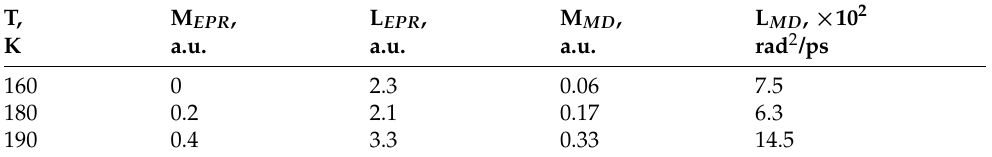
Table 1. Comparison of parameters of mobility and libration measured in EPR and MD experiments vs. temperature. The error of both experimental and calculated values does not exceed ∼ 10%.